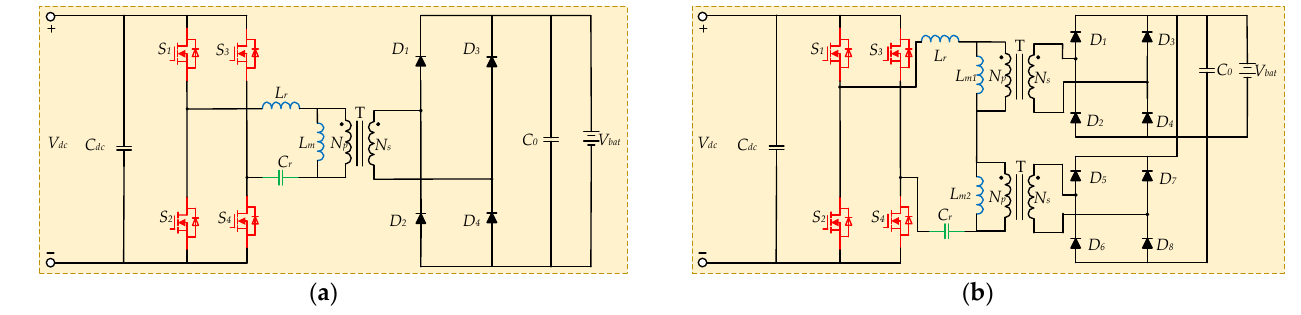
Figure 10. LLC resonant converter. ( a ) LLC resonant converter. ( b ) LLC resonant converter with series-parallel transformer.